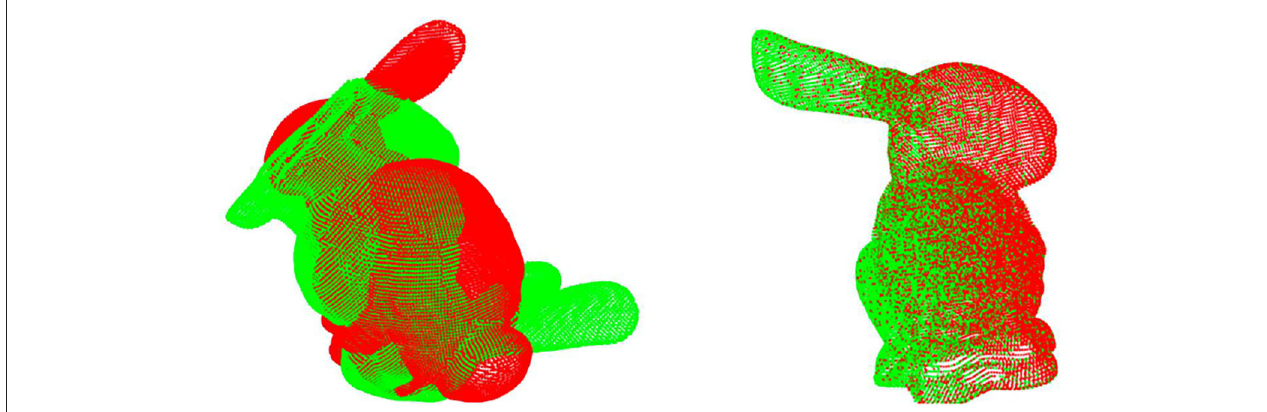
FIGURE 4 | DeepMatch completes the registration on unseen categories.